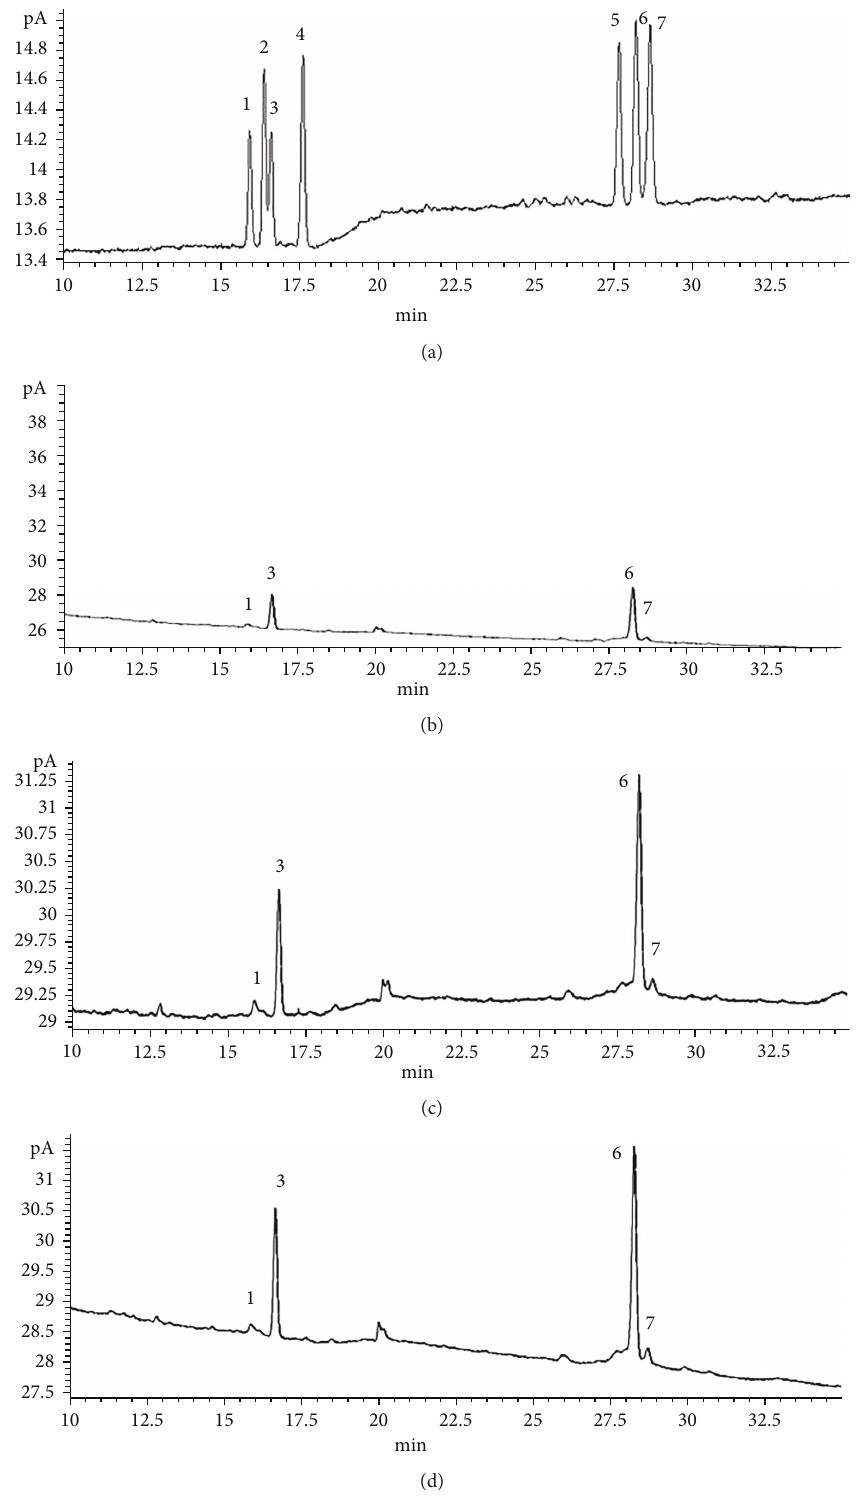
Figure 3: Gas chromatography-mass spectrometry (GC-MS) results of APS. (a) Gas chromatogram of standard monosaccharides. (b) Monosaccharide component of APS1. (c) Monosaccharide component of APS2. (d) Monosaccharide component of APS3. 1: rhamnose; 2: fucose; 3: arabinose; 4: xylose; 5: mannose; 6: glucose; 7: